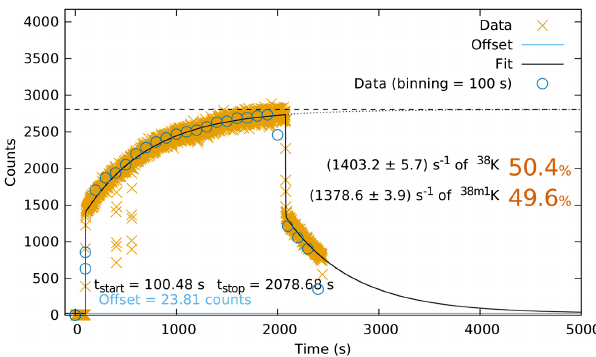
FIG. 2. Example output of the fitting function used to analyze the beta decay curves and determine the isomeric ratio. The ground state and isomer lifetimes are known; the implantation time, beam-off time, run stop time, and offset (background counts due to the remaining decay from the previous decay spectrum measurement) are left as free parameters in the